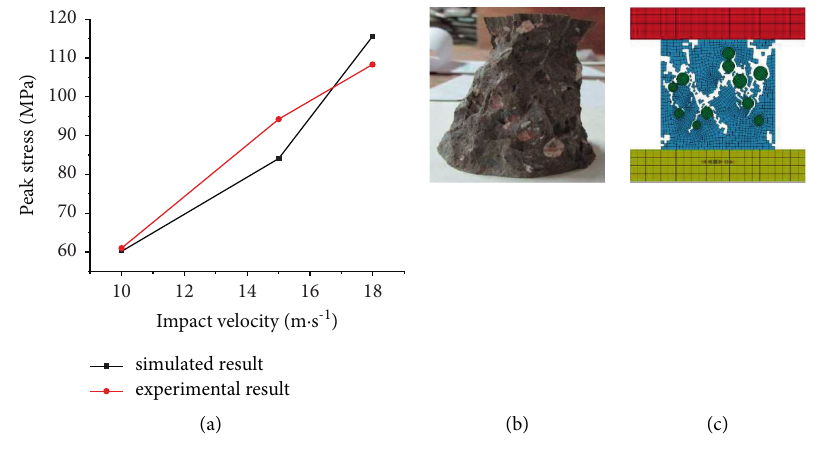
Figure 6: Comparison of desert sand concrete between experimental and simulated results.